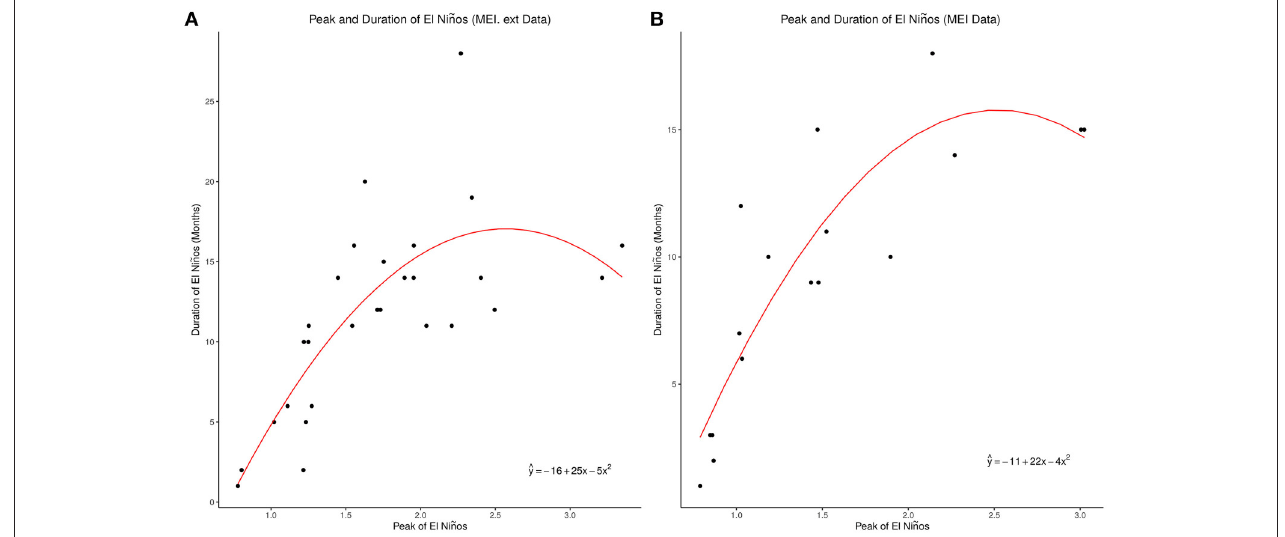
FIGURE 5 | Dendogram and heatmap of MEI.ext data.